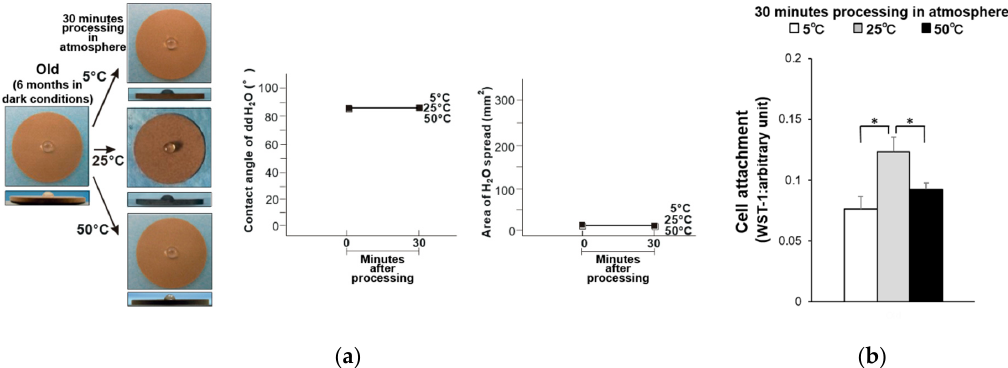
Figure 1. ( a ) Hydrophobicity/hydrophilicity of the old–dry titanium disk surfaces illustrated as a photograph of 10 µL ddH 2 O placed on the sample surface before and after temperature deviation (left) with the corresponding contact angle (middle) and spread area (right). ( b ) Initial attachment of osteoblasts to the old–dry titanium disk surfaces. * p < 0.05, statistically significant difference.